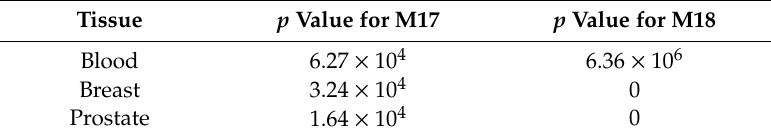
Table 7. Significance of target modules M17 and M18 for TSA in the three TSPPI networks.